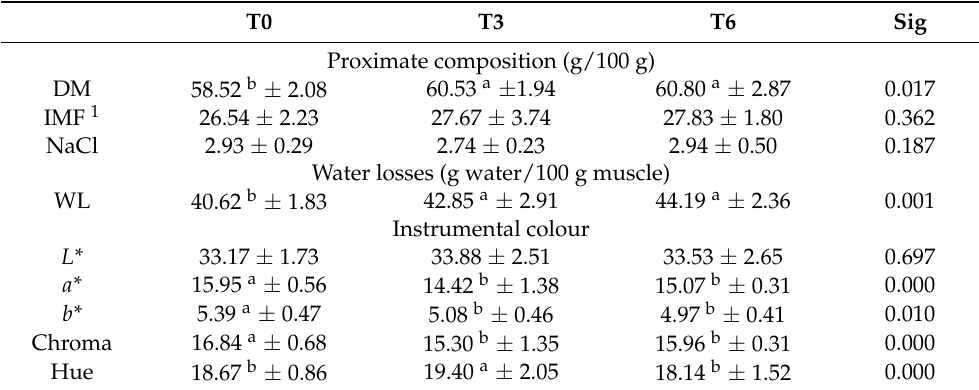
Table 1. Proximate composition, weight loss and instrumental colour of Montanera Iberian dry-cured lomito as affected by pre-cure freezing